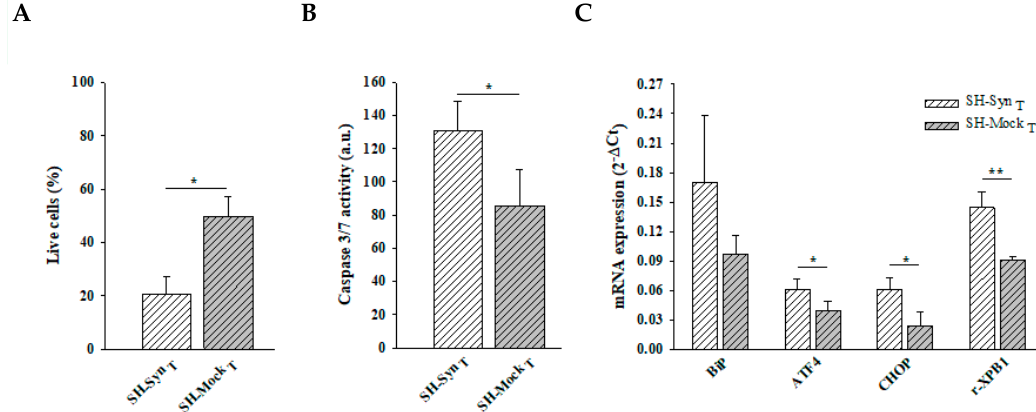
Figure 3. Cell viability, executioner 3 / 7 caspase activity, and UPR induction in SH-Syn T . ( A ) Live cell count by Trypan blue staining of SH-Syn T and SH-Mock T . Data are presented as the means ± SD from three independent experiments, each performed in triplicate. Data were analyzed by a two-tailed Student’s t -test (* p < 0.05). ( B ) Analysis of caspase 3 / 7 activity in SH-Syn T and SH-Mock T . Data are presented as the means ± SD from two independent experiments, each performed in triplicate. Data were analyzed by a two-tailed Student’s t -test (* p < 0.05). ( C ) BiP, ATF4, CHOP, and r-XBP1 mRNA quantification by qPCR in SH-Syn T and SH-Mock T . Data are presented as the mean ± SD of three independent experiments, each performed in duplicate. Data were analyzed by a Mann–Whitney Rank Sum Test (* p < 0.05, ** p < 0.001).